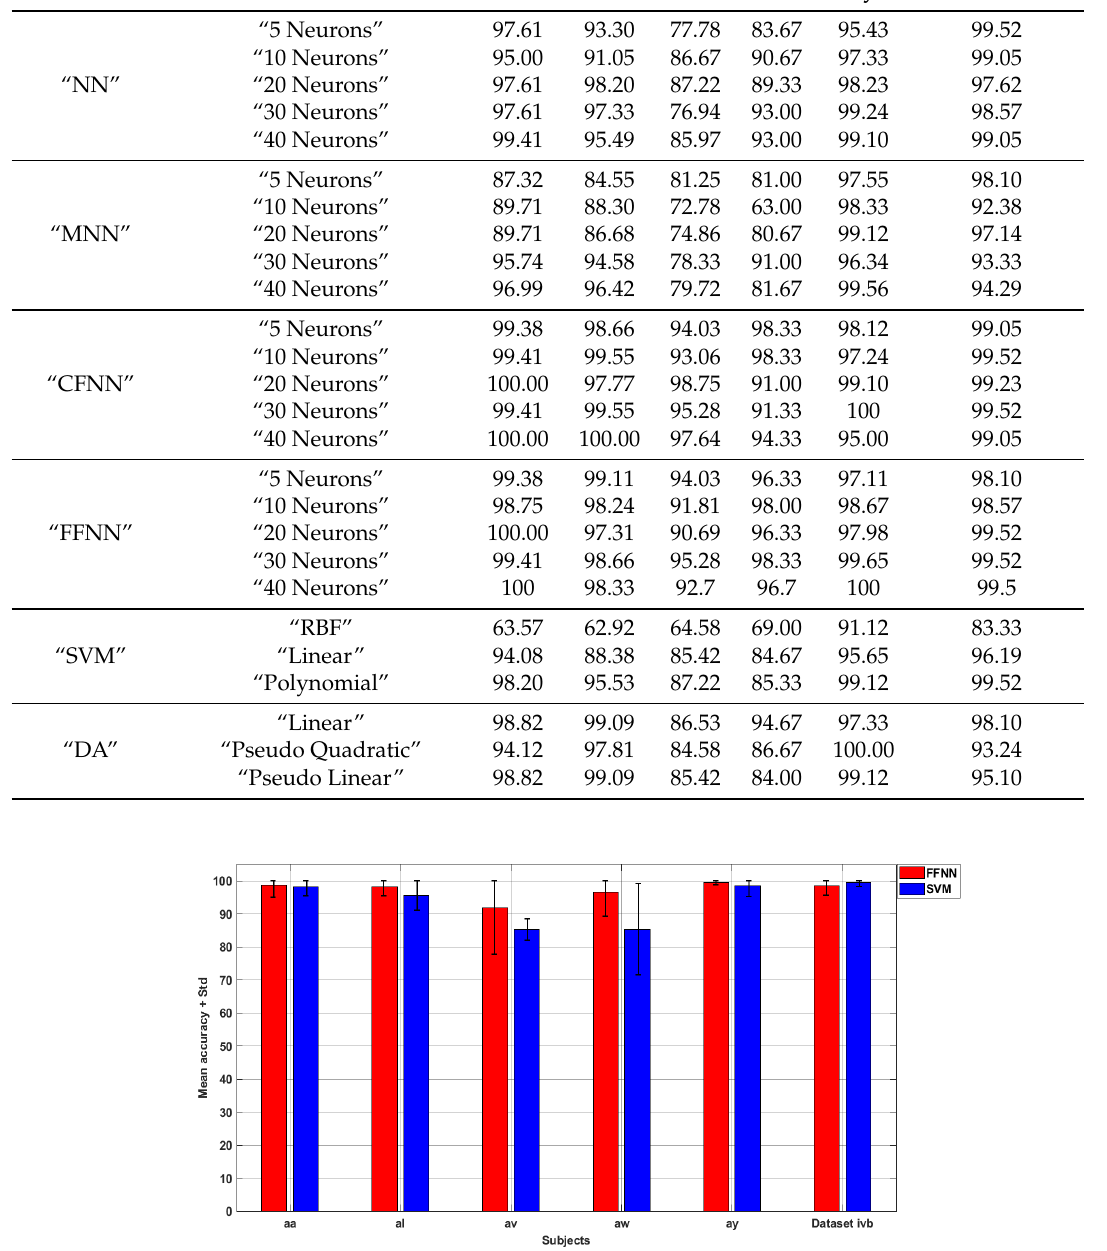
Figure 7. Results obtained with 10-fold 10